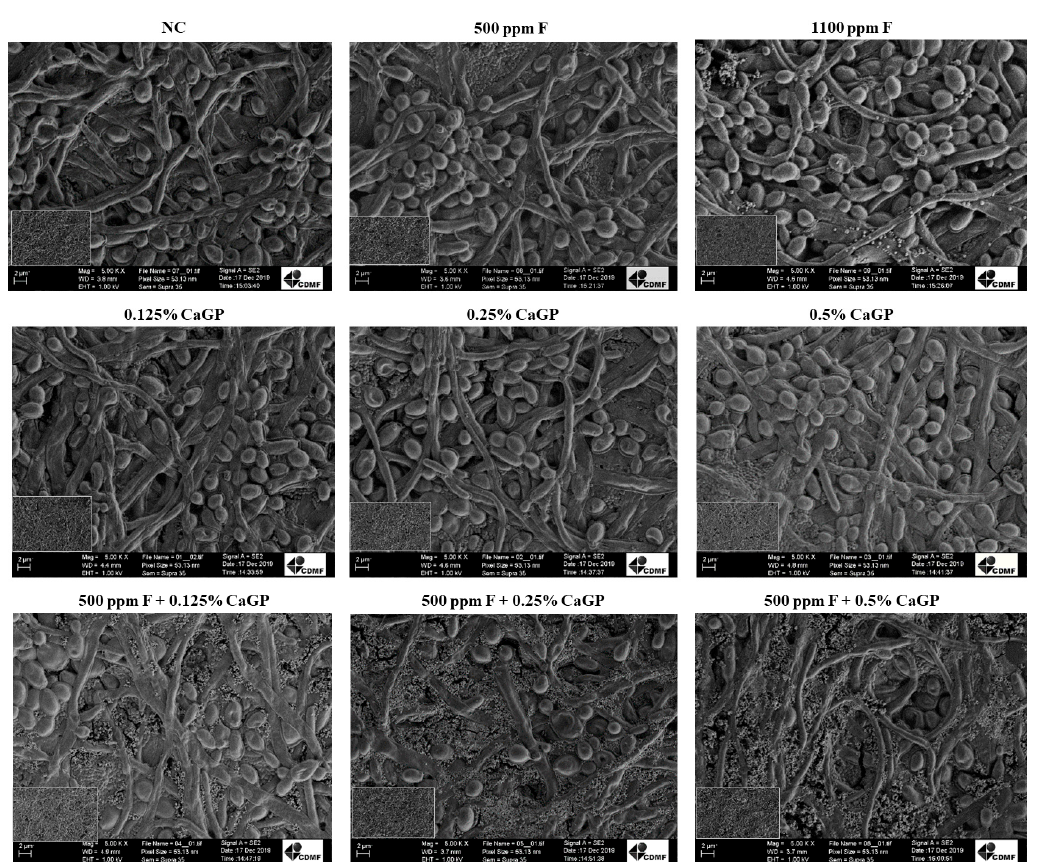
Figure 3. Scanning electron microscopy images of dual-species biofilms of Candida albicans and Streptococcus mutans after treatments with the experimental solutions. Magnification: 5000×. Bars: 2 mm. NC: negative control (untreated biofilms); CaGP: calcium glycerophosphate; F: fluoride.